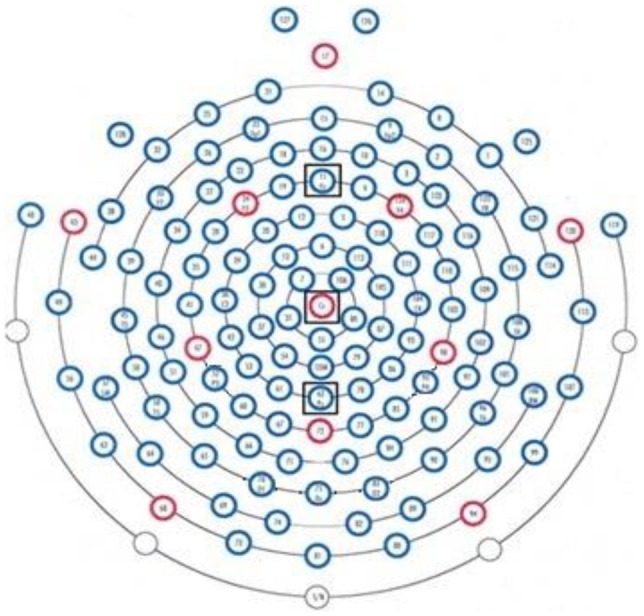
Placement of Electrodes (HydroCel Geodesic Net; Amin et al., 2015a).